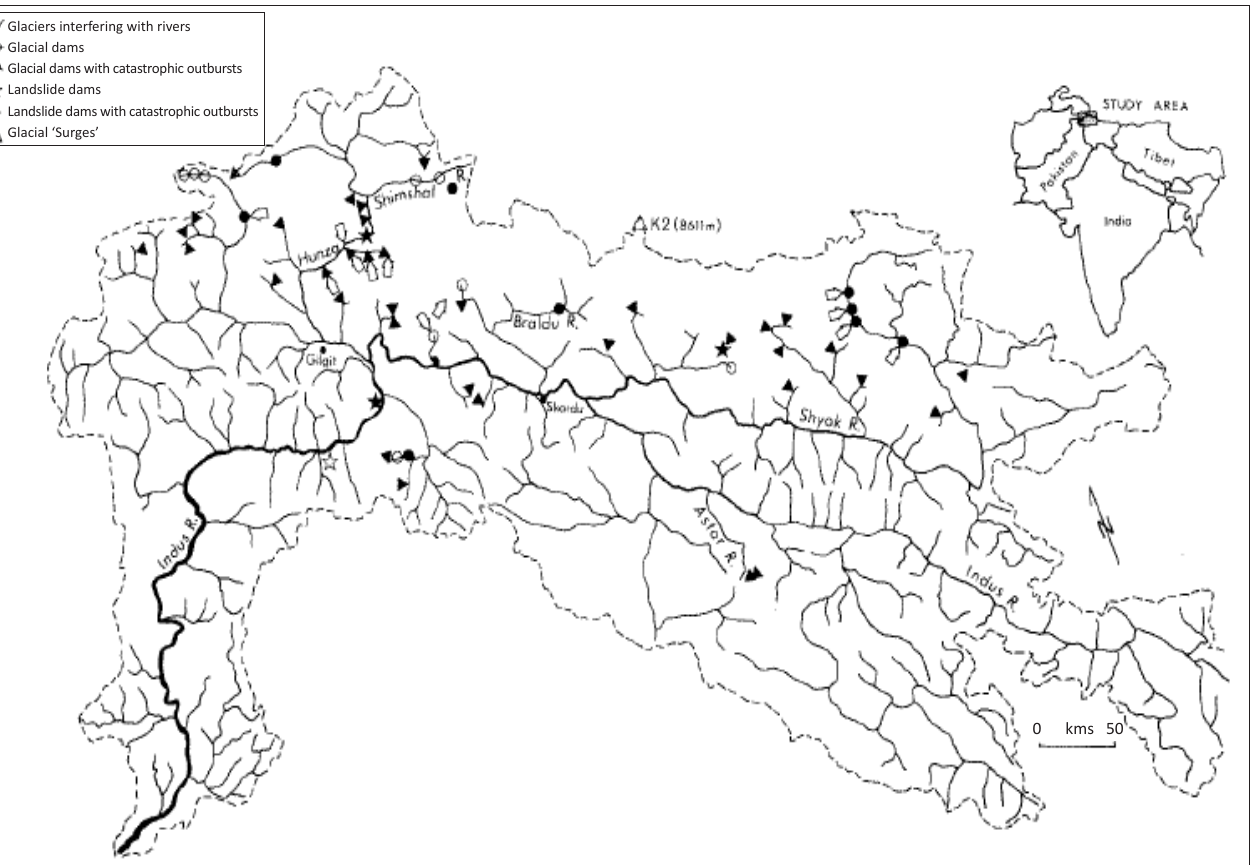
Source : Hewitt, K., 1982, ‘Natural dams and outburst floods of the Karakoram Himalaya’, in J.W. Glen (ed.), Hydrological aspects of alpine and high mountain areas – International Association of Hydrological Sciences Publication 138, Proceedings of the 2nd Exeter Symposium, Exeter, 19–30 July, pp. 259–270 FIGURE 7: Distribution of glacial lakes and related glacial events in the upper Indus River basin.